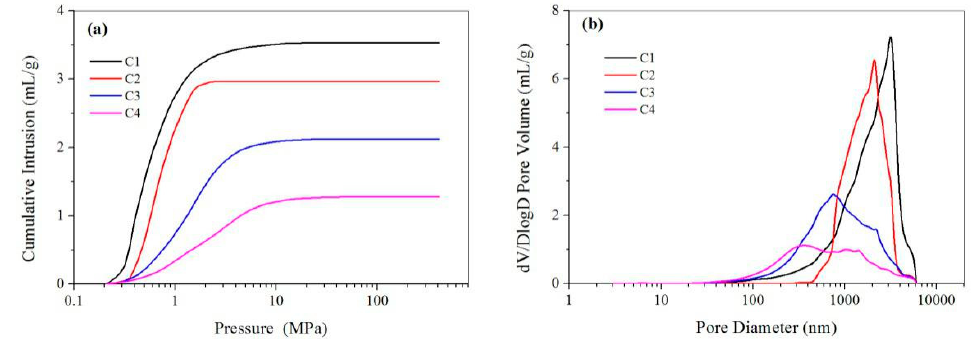
Figure 10. ( a ) Cumulative mercury intrusion traces and ( b ) pore size distribution of the CMC/CA microspheres fabricated with Cu(II) content of 25mM (C1), 50mM (C2), 100mM (C3), and 200mM (C4) in the outer aqueous solution.